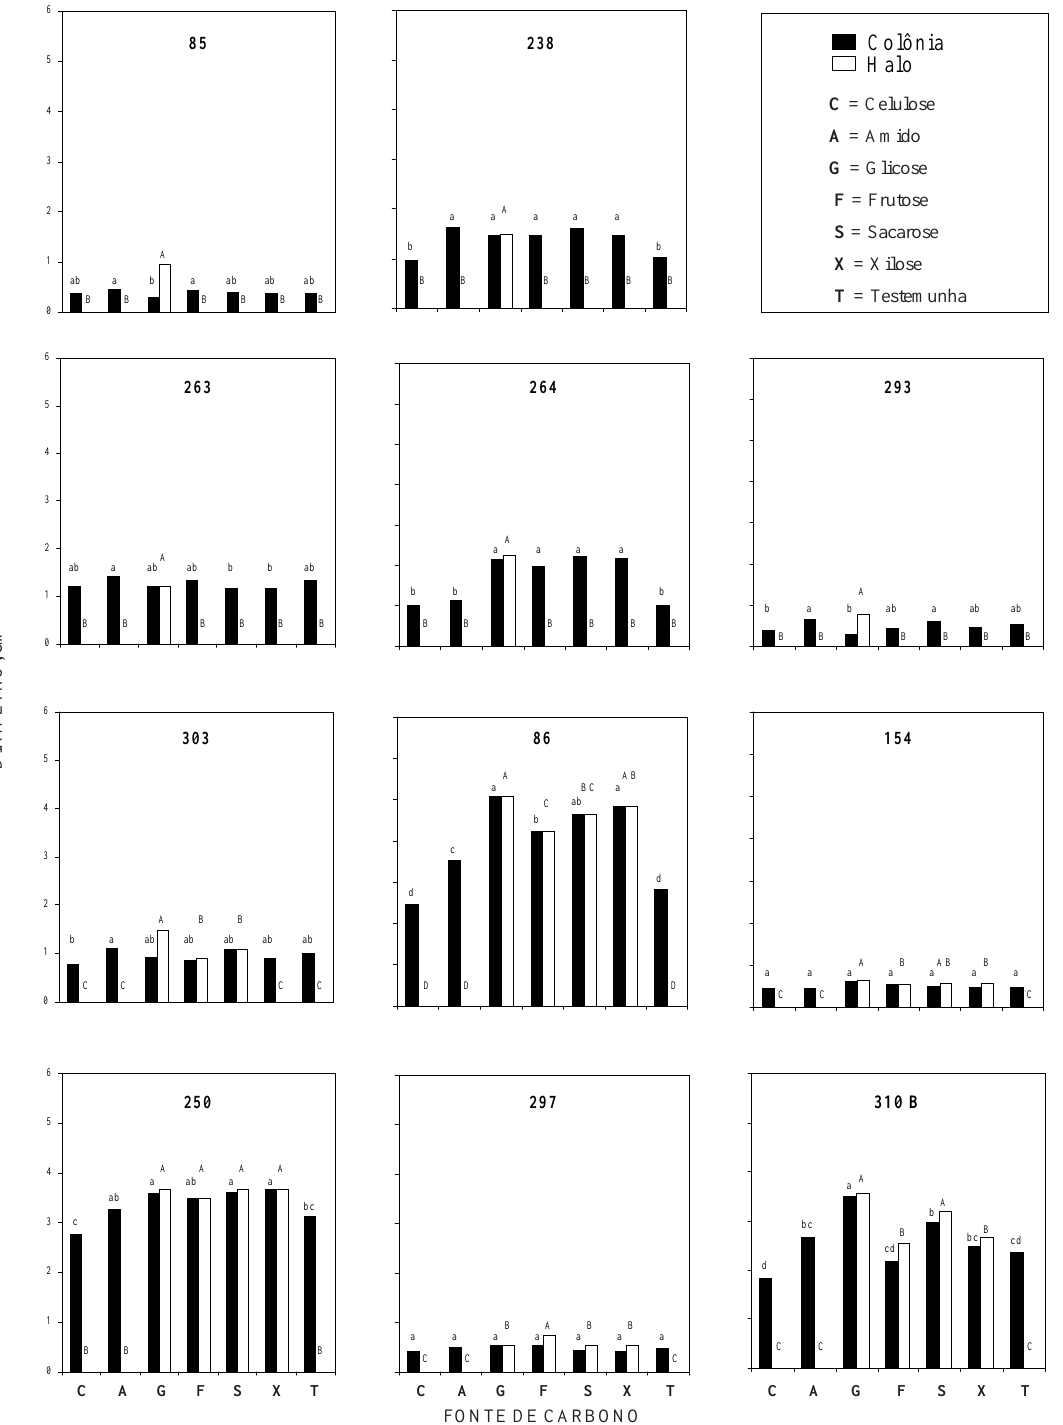
Figura 2. Efeito de fontes de carbono no crescimento e na capacidade de solubilizar fosfato de cálcio dos isolados 85, 86, 154, 238, 250, 263, 264, 293, 297, 303 e 310 B. Letras minúsculas e maiúsculas comparam em cada isolado o diâmetro de colônia e da área solubilizada, respectivamente, pelo teste de Tukey a